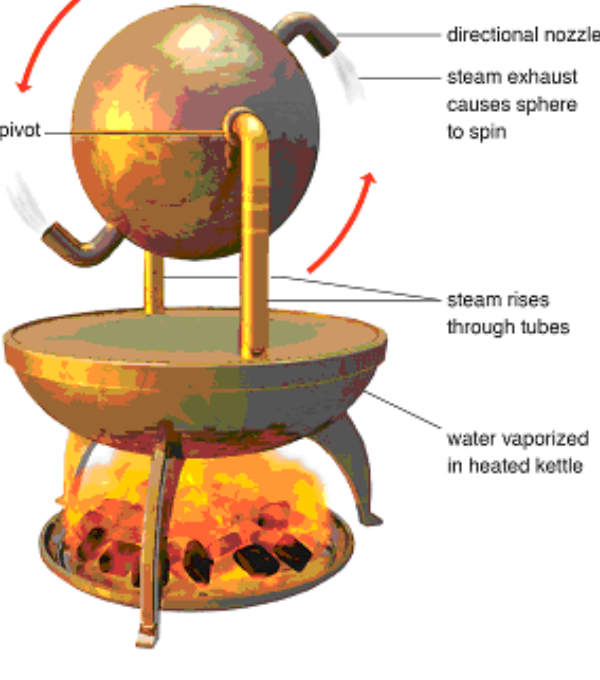
Figure 14. Heron’s aeolopile